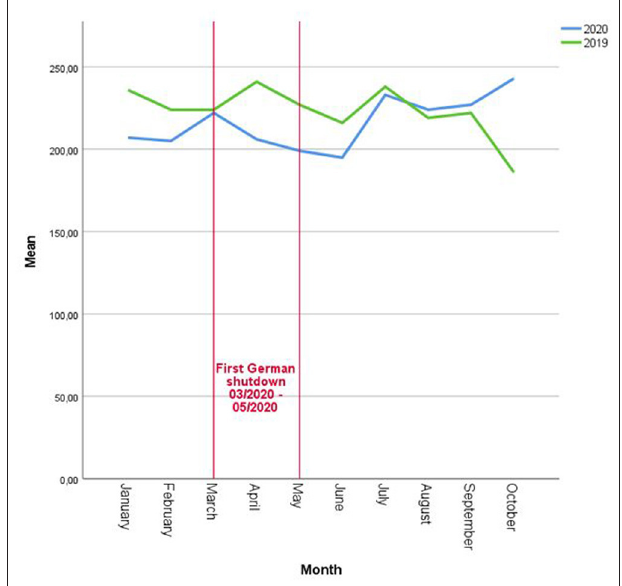
FIGURE 1 | The number of tumor board presentations per month/year 2019 (pre-COVID-19 pandemic) vs. 2020 (during COVID-19